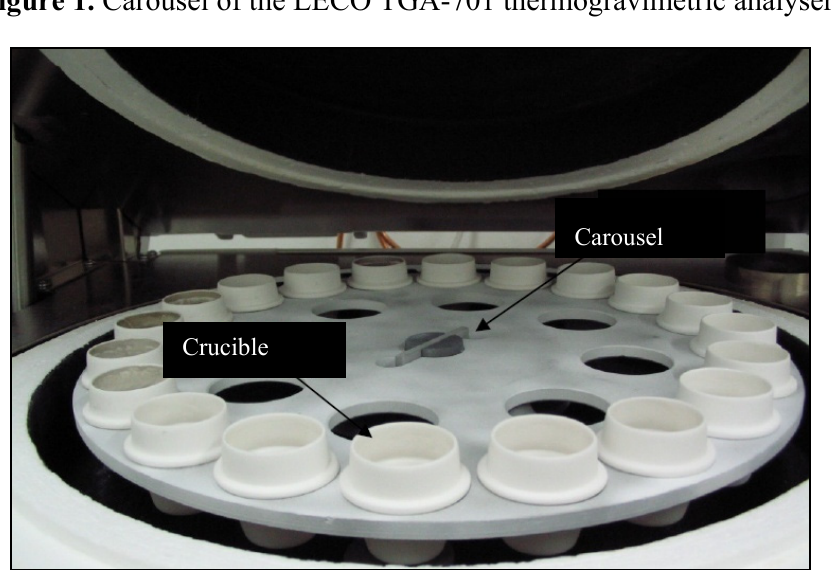
Figure 1. Carousel of the LECO TGA-701 thermogravimetric